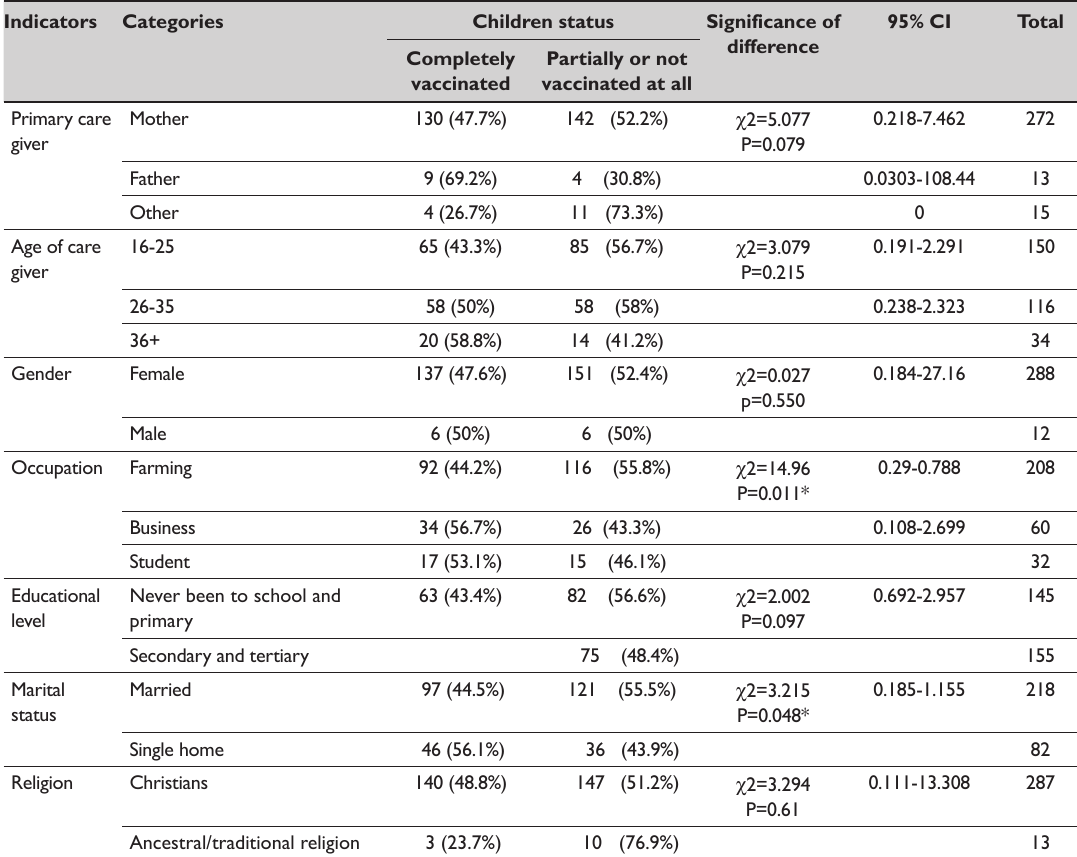
Table 3: Demographic factors affecting vaccination coverage in the MHA